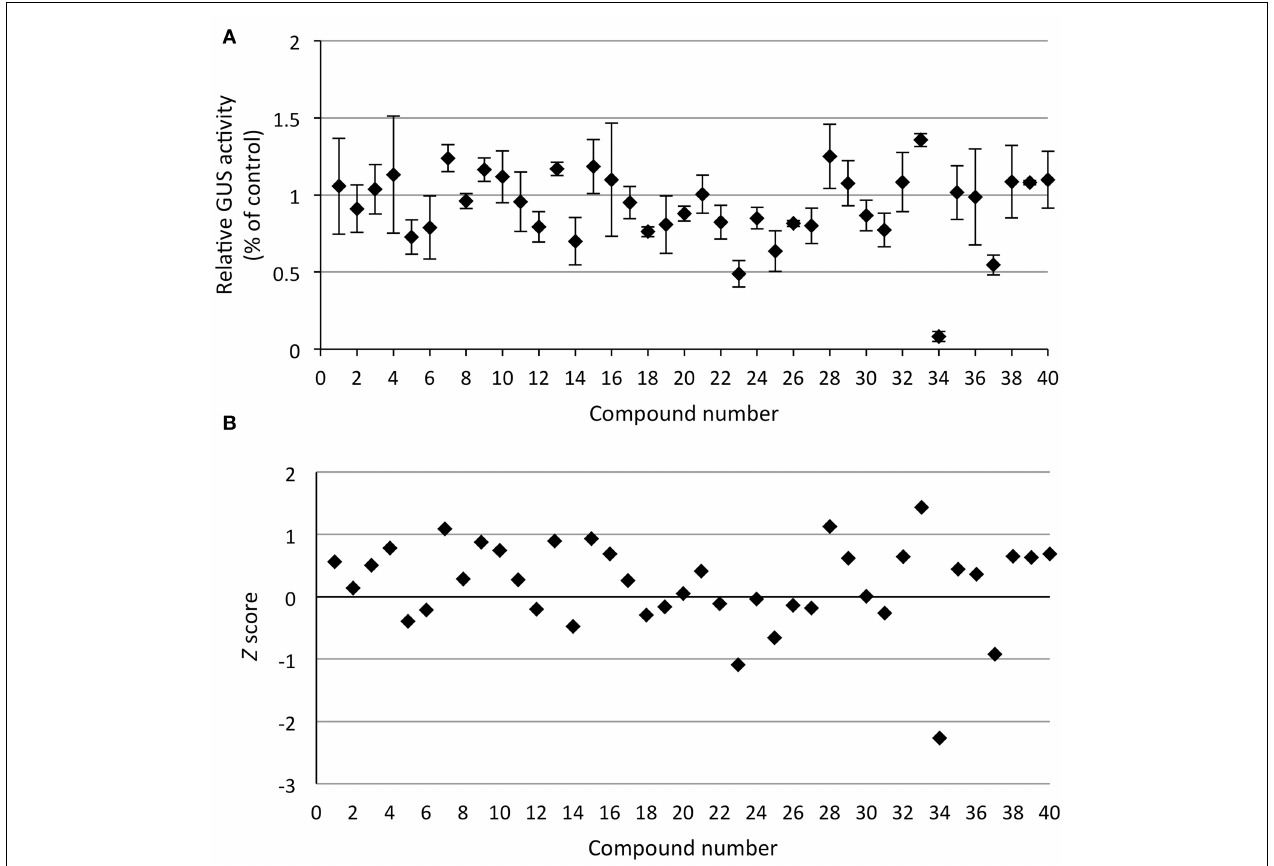
FIGURE 8 | Screening for inhibitors of SA signaling. Arabidopsis seedlings harboring the SA-responsive PR1p::GUS reporter gene, grown for 12 days in liquid culture, were treated with 40 diverse chemicals (20 μ M) for 1h prior to addition of SA (200 μ M) to induce reporter gene expression. (A) GUS activity of whole seedlings ( in situ ) was quantified by incubation with 4-MUG (1mM) for 90min (see Materials and Methods) and normalized to the SA-treated control samples. Values represent the mean of duplicate samples and the